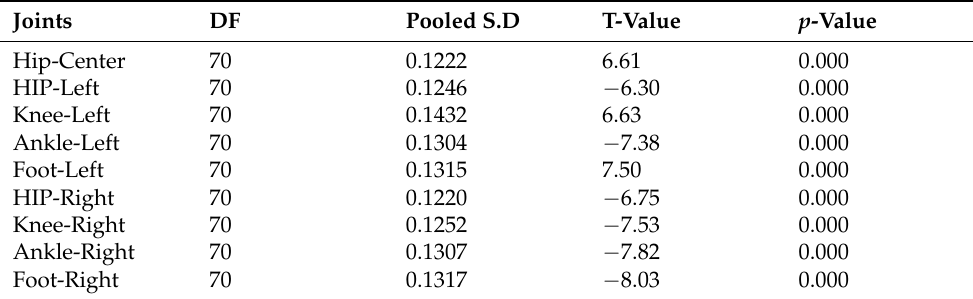
Table 3. Results of a two-sample t-test used to compare male and female joints when walking. Joints DF